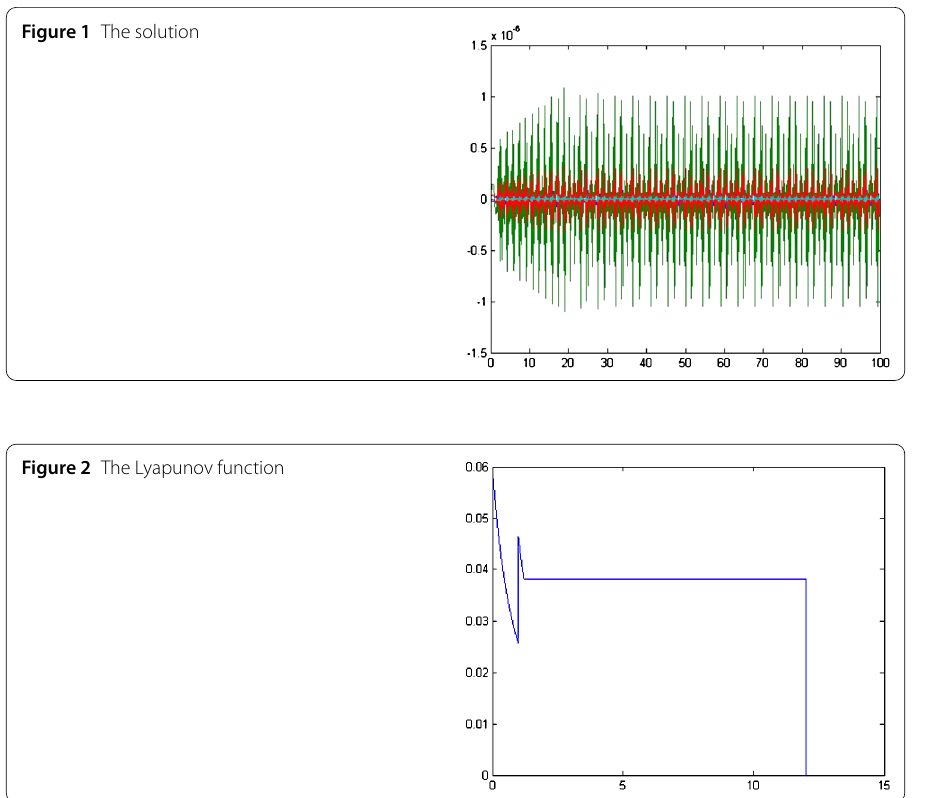
Figure 1 The solution